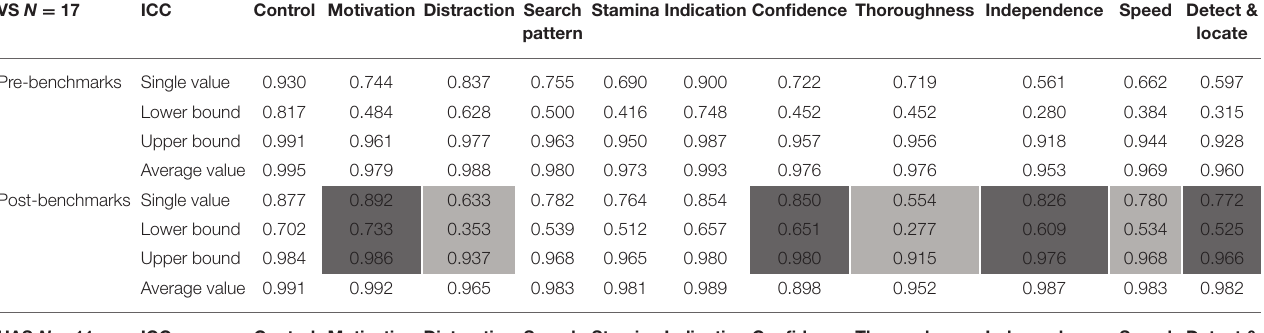
TABLE 2 | Single rater agreement (ICC) between 11 raters, with 95% confidence intervals (upper and lower bounds) and average rater ICC for comparison. VS N = 17